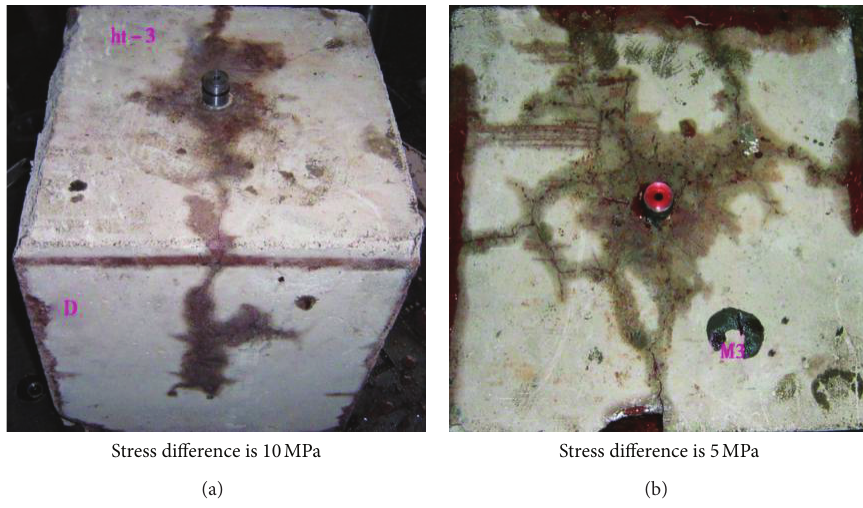
Figure 8: Experimental results contract of fracture propagation pattern for different stress difference [12].